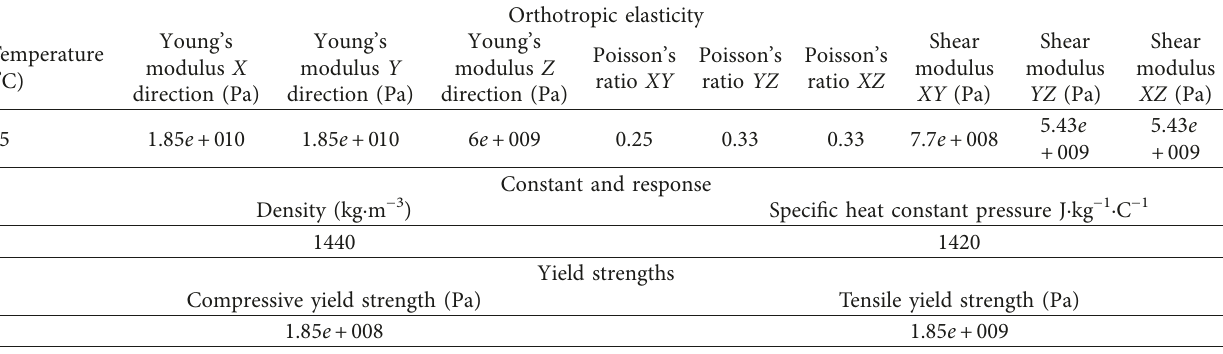
Table 5: Mechanical properties of Kevlar 29. XY axes lie in the plane of the layers whereas Z is perpendicular to the layer [14].